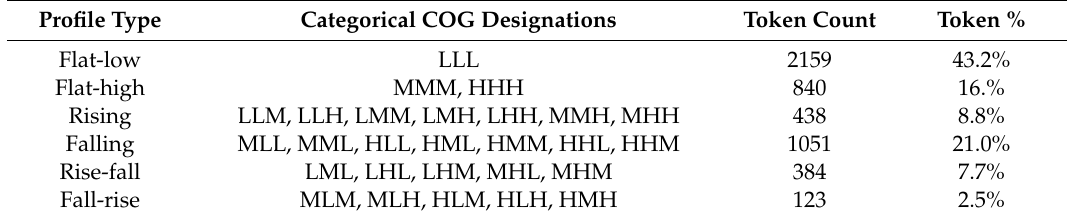
Table 5. Profile categorization.